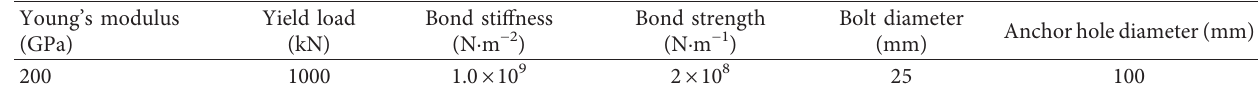
Figure 2: Model for seismic analysis of surface structures and free-field mesh. Table 2: Mechanical parameters of the rock